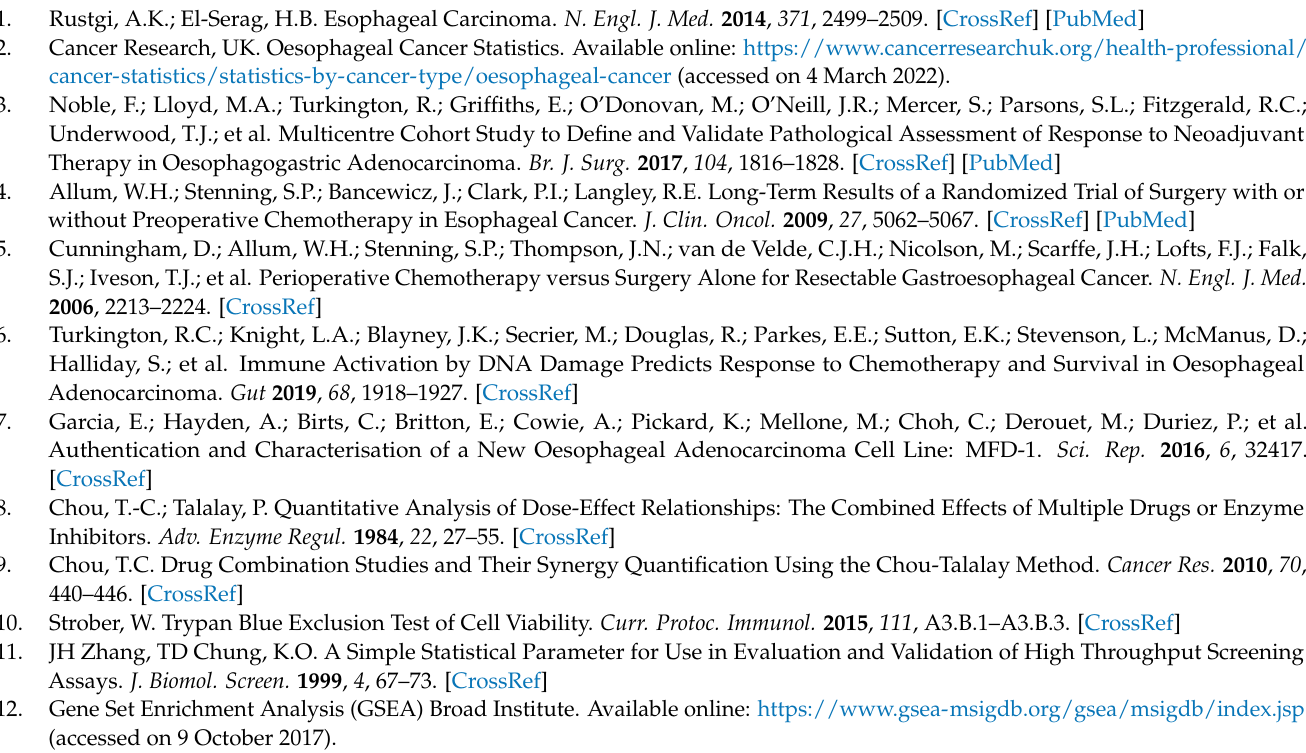
Figure S5: Src expression data in gastric adenocarcinoma, Table S1: Enriched genelist, Table S2: OAC cell line drug sensitivity, Table S3: Positive hits from compound